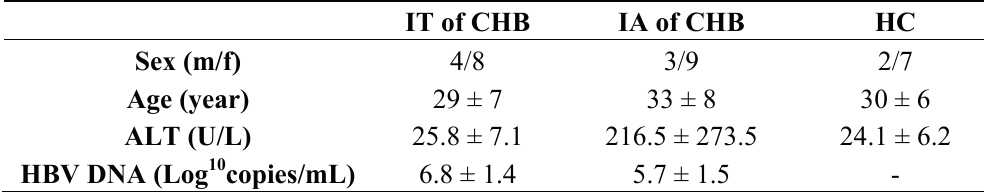
Table 2. Baseline data of group detected by